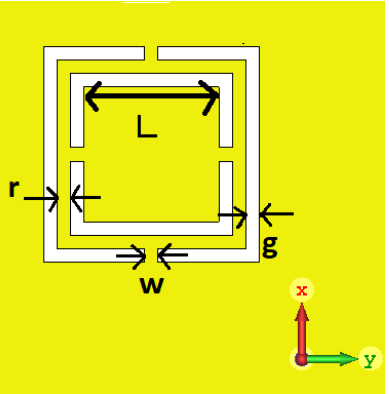
Figure 1. Proposed sensor’s perspective view with PCB substrate hidden.